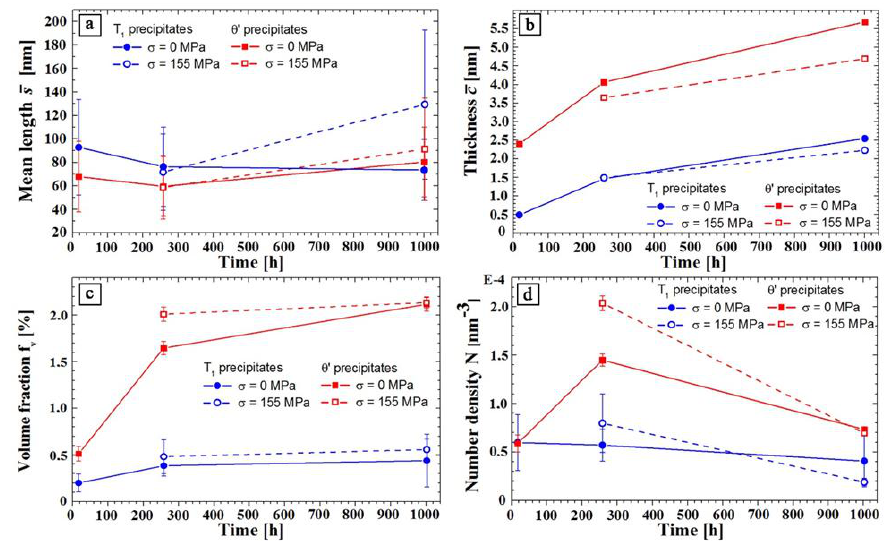
Figure 9. Evolution of the characteristics of T 1 (blue) and θ (cid:48) (red) precipitates vs. aging/creep time: Figure 9 . Evolution of the characteristics of T 1 (blue) and  ' (red) precipitates vs. aging/creep time: ( a ) ( a ) mean line length s ; ( b ) mean thickness c ; ( c ) volume fraction f v ; and ( d ) number density N mean line length 𝑠̅ ; ( b ) mean thickness 𝑐̅ ; ( c ) volume fraction 𝑓 𝑣 ; and ( d ) number density N .